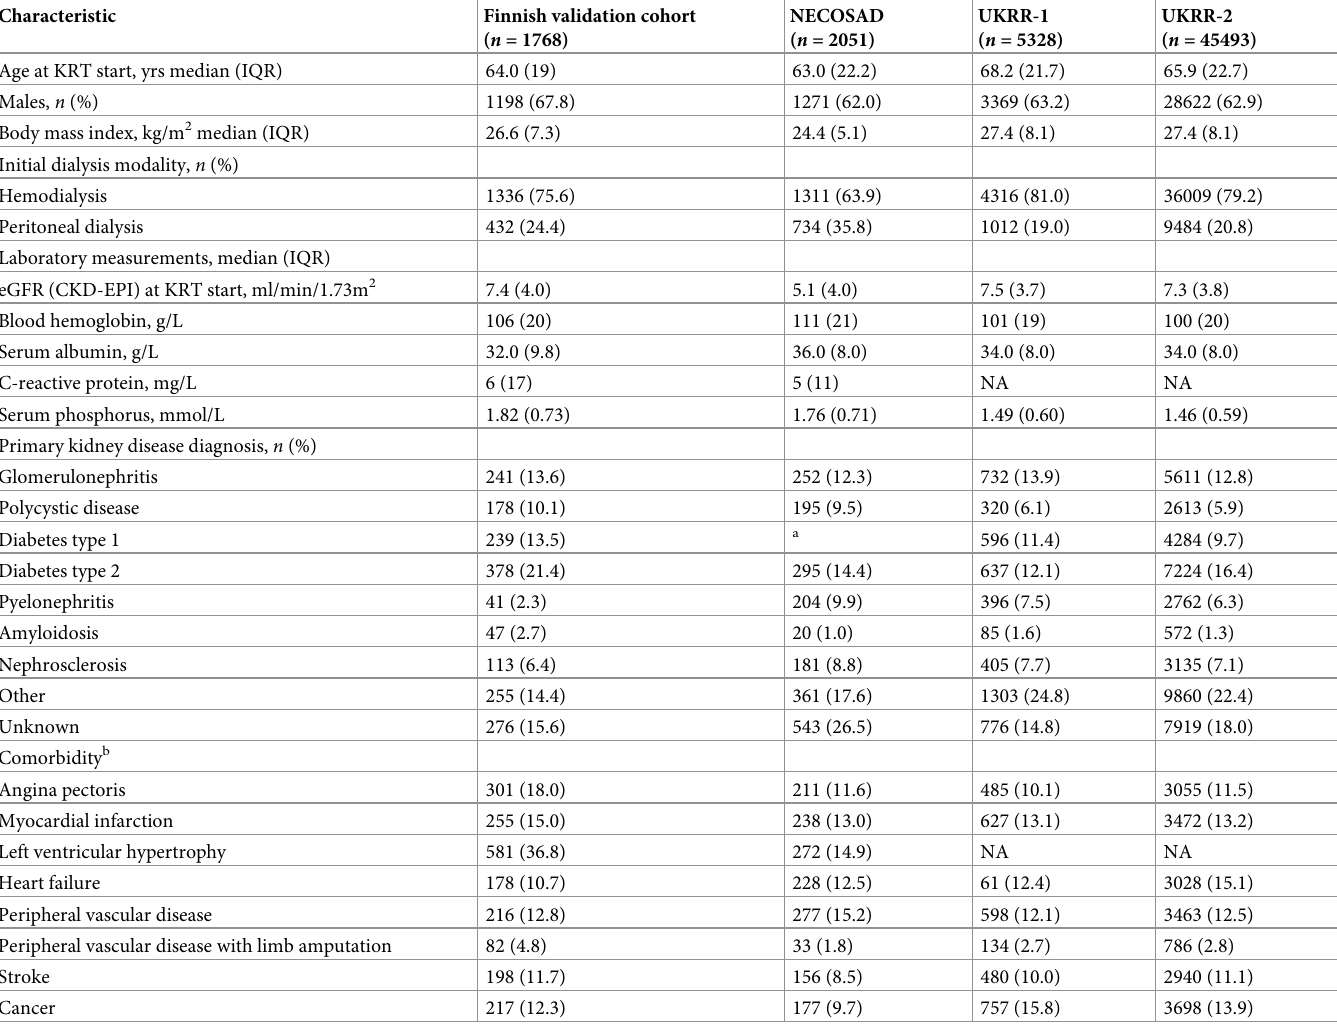
Table 2. Baseline patient characteristics according to data